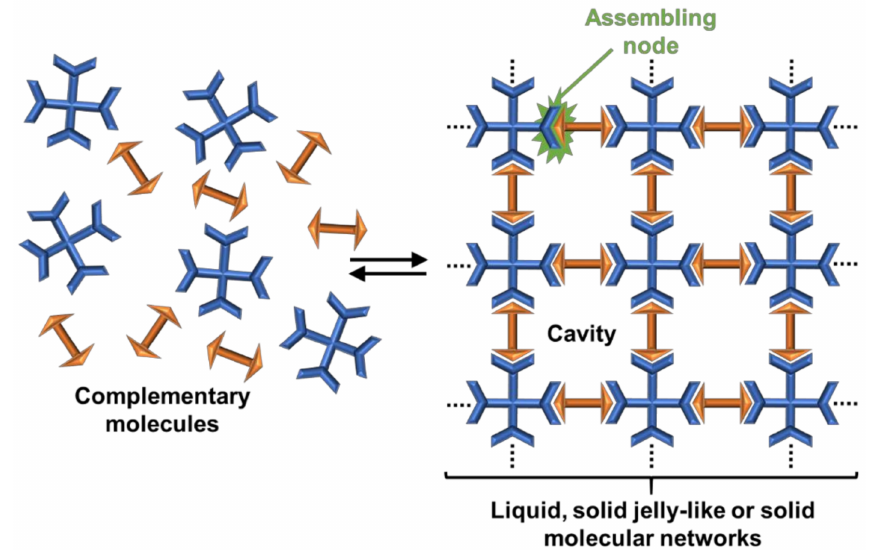
Figure 37. Engineering of extended supramolecular networks from the ordered aggregation of molecules to obtain liquid, solid jelly-like, or solid